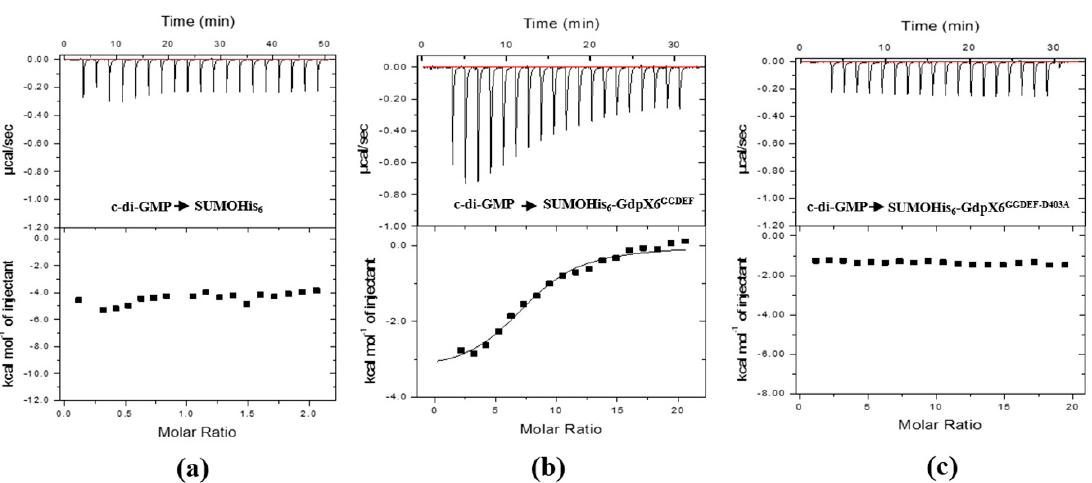
Figure 3. The binding activity of the GdpX6 with c-di-GMP were analyzed using isothermal titration calorimetry assays. The titration calorimetry of 30 µ M SUMOHis 6 , 10 µ M SUMOHis 6 -GdpX6 GGDEF , and 10 µ M SUMOHis 6 -GdpX6 GGDEF-D403A were syringed into the cell pool and 2 µ L aliquots of 300 µ M, 1 mM, or 1 mM c-di-GMP at 25 ◦ C. The c-di-GMP binding to the con- trol protein SUMOHis 6 ( a ), the recombinant proteins SUMOHis 6 -GdpX6 GGDEF ( b ) and SUMOHis 6 -GdpX6 GGDEF-D403A ( c ).